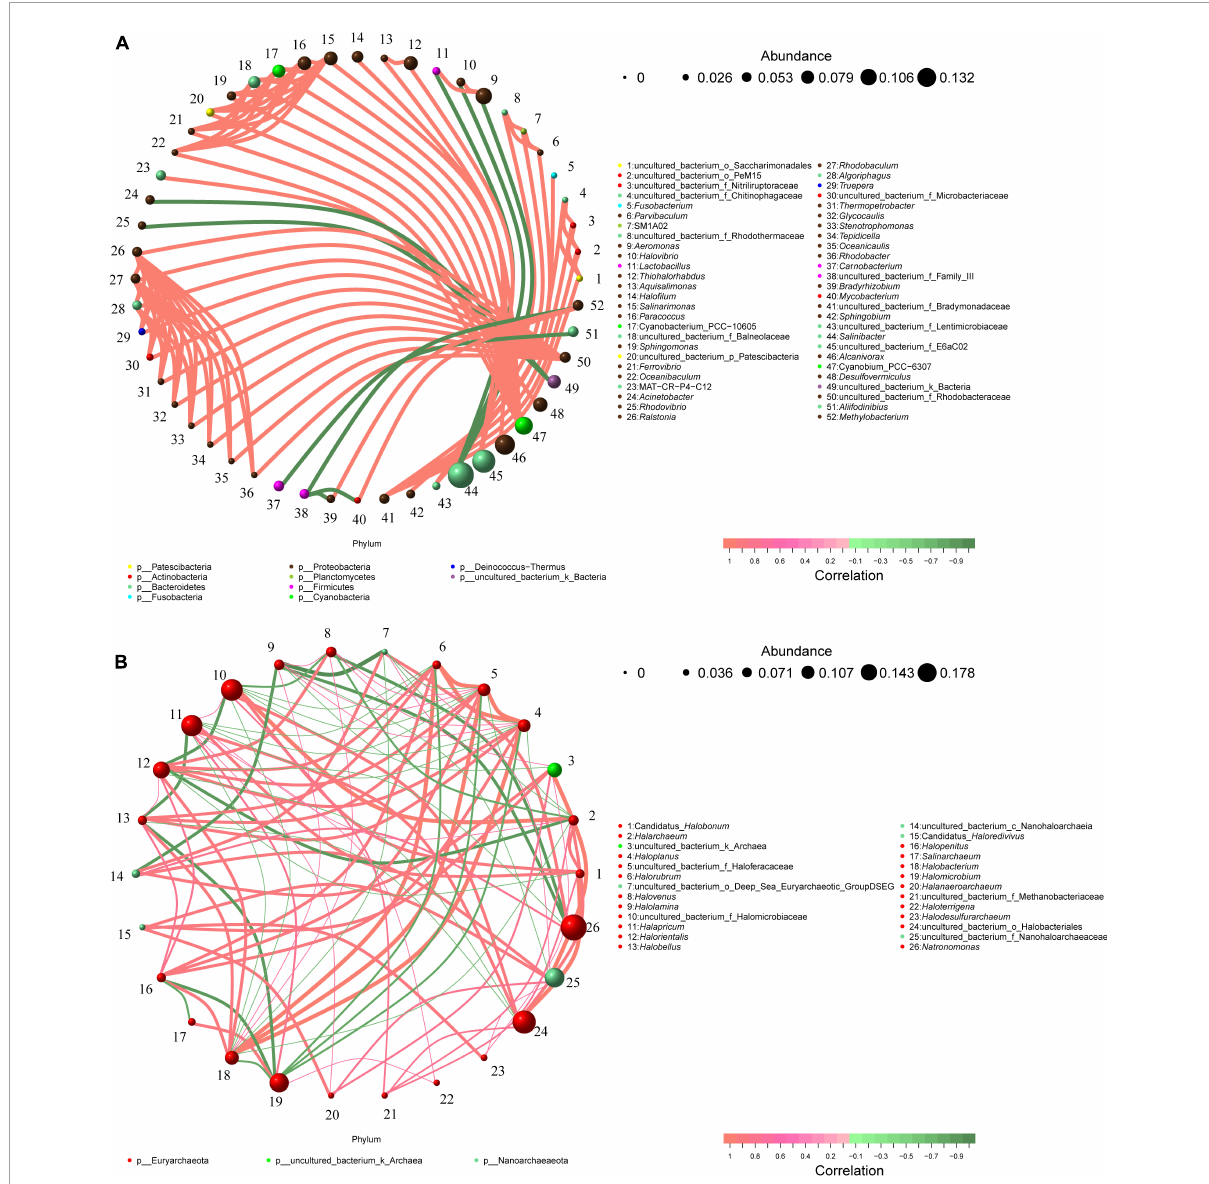
FIGURE7 Co-occurrence networks of microbial communities in different brine samples based on correlation analysis. The nodes in network are colored by phylum. Co-occurrence networks of bacterial communities (A) and archaea communities (B) ; The connections indicate strong spearman’s ( ρ > 0.7) and significant ( p < 0.05) correlations. The size of each node is proportional to the relative abundance of specific